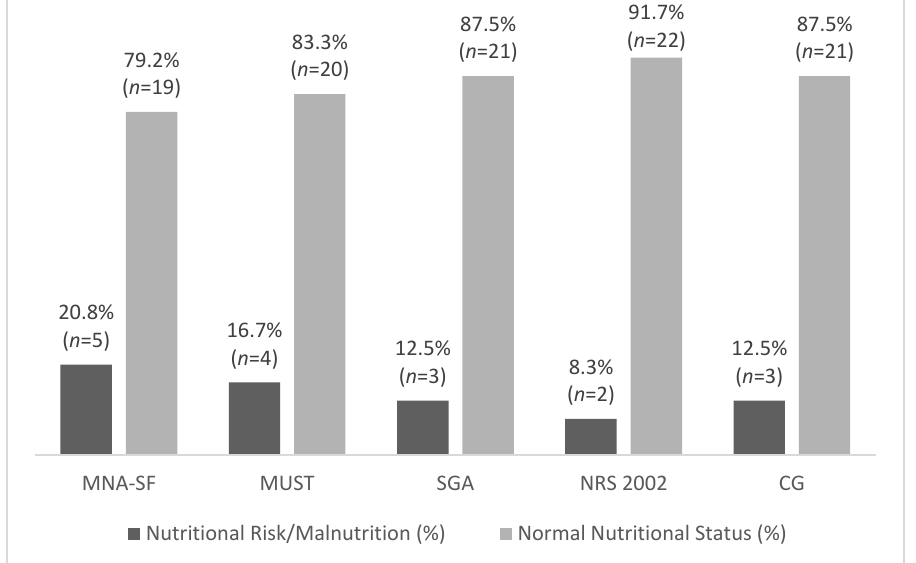
Figure 2. Percentage mean value obtained from each nutritional assessment and screening tool in day